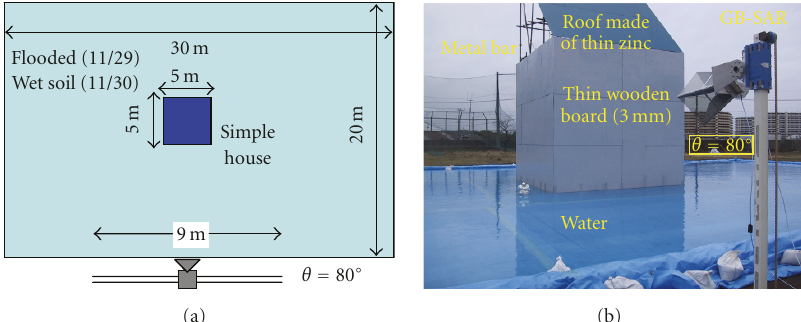
Figure 3: (a) Configuration of the field experiment. (b) Photo of the simple house and GB-SAR, which was deployed outside the water.